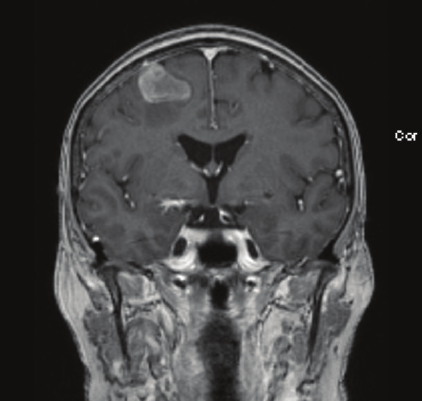
Figure 3: 2014 MR image, coronal